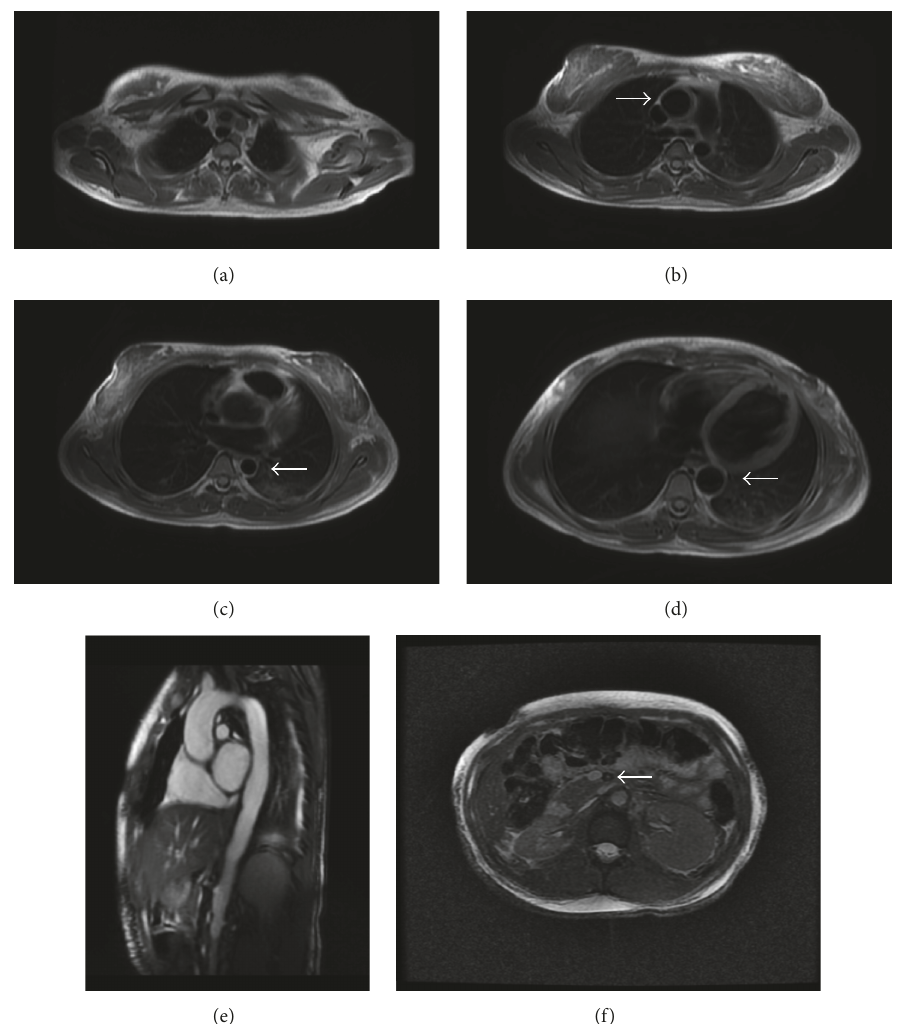
Figure 2: MRI/MRA through the chest, abdomen, and pelvis was obtained. (a) Axial double inversion recovery sequence through the upper chest demonstrates mural thickening of the brachiocephalic, left common carotid, and left subclavian arteries. (b) Axial double inversion recovery sequence demonstrates mural thickening of the ascending aorta which measures 3.4 cm in diameter. (c) Axial double inversion recovery sequence demonstrates a focal narrowing of the descending aorta, measuring 2.2 cm. (d) Inferior to the focal narrowing visualized in (c), the aorta measures 3.2 cm on axial double inversion recovery sequence. (e) Sagittal oblique cine-FIESTA sequence demonstrates the undulating contour of the abdominal aorta. (f) Axial T2 FIESTA fat saturated sequences through the abdomen demonstrate wall thickening and mural narrowing of the superior mesenteric artery. The white arrow represents in (b) ascending thoracic aorta; (c) and (d) descending thoracic aorta; (f)